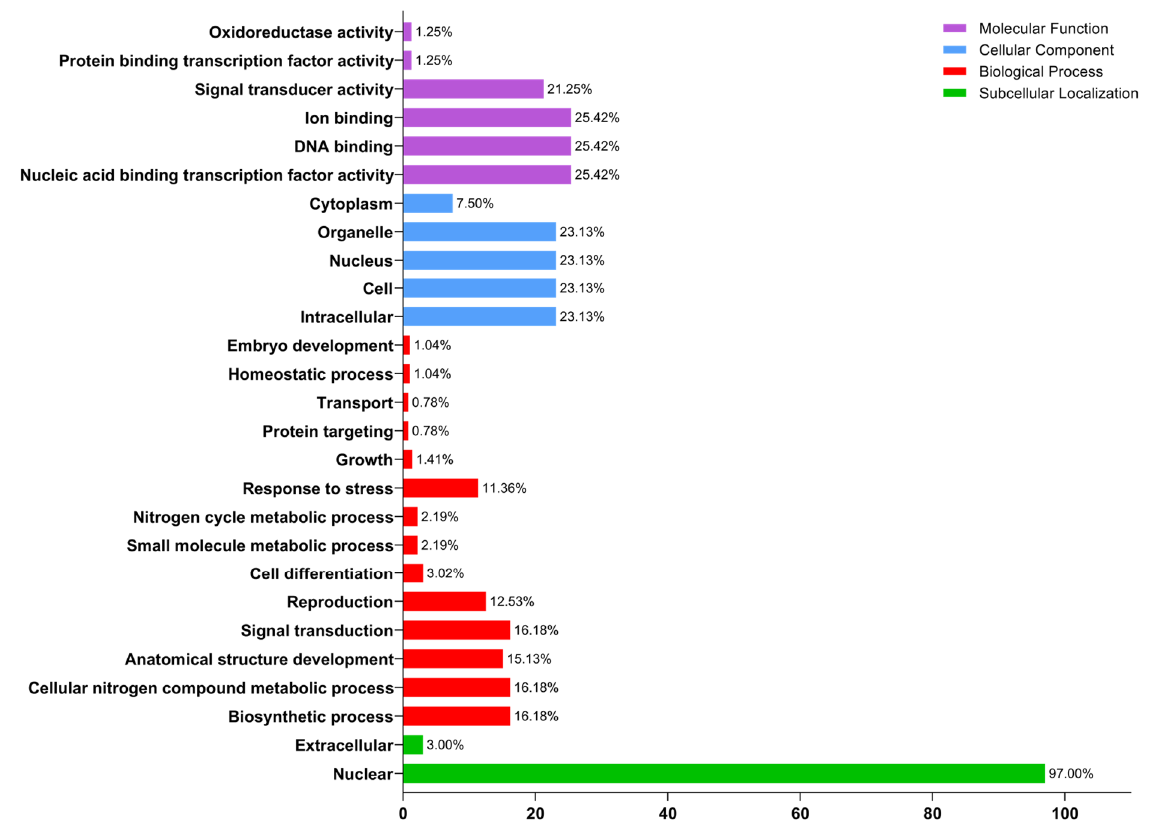
Figure 3. GO annotations enrichment analysis for GATA proteins. The GO annotation is divided into four main categories: molecular function, cellular component, biological process, and subcellular localization. The y-axis on the right represents the percentage of genes in each category and the left showed the Go target functions.